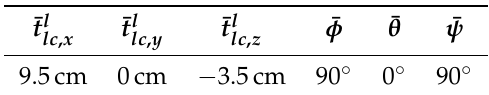
Table 1. Simulated pose between the laser and